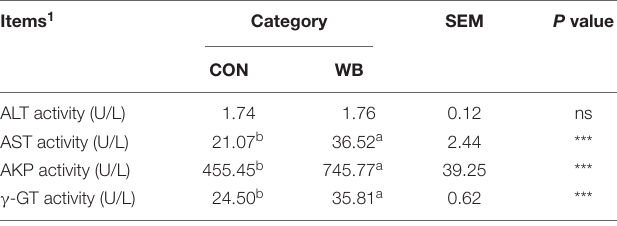
TABLE 1 | Enzymatic activities in serum of broiler chickens with normal (CON) and wooden breast (WB) pectoralis major muscle ( n = 10).